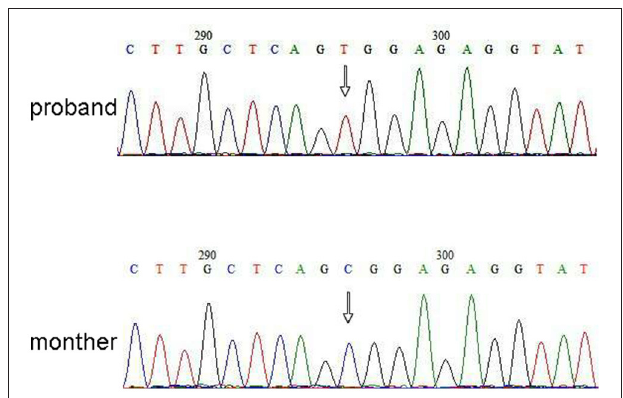
FIGURE 3 | Sanger sequencing validation for the mutation of RPS6KA3 in the proband at chromosome Xp22. A mutation of c.2185C > T was detected in imprinting control region from allele 290–300, which was not detected in proband’s mother.